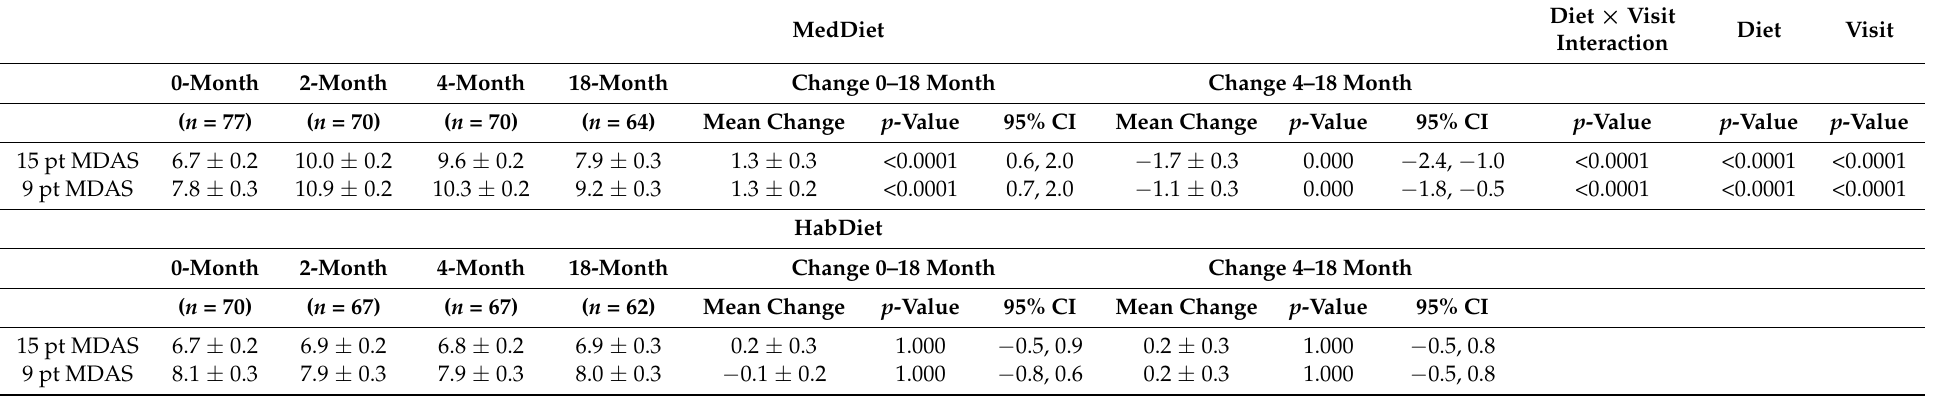
Table 1. Mediterranean diet adherence measured according to two scores: 15-point score and 9-point literature-based score.